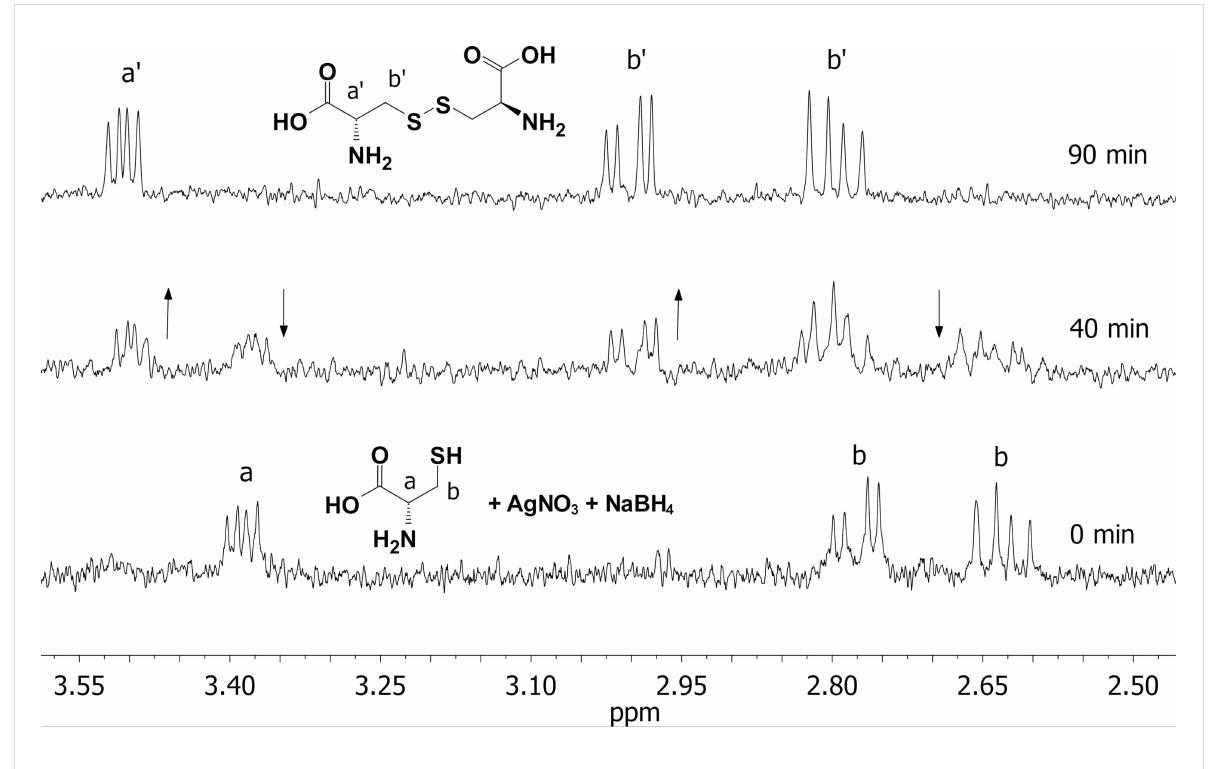
Figure 1: 1 H NMR spectra of the reaction mixture aliquots (5.6 mM cysteine, 56 mM NaBH 4 , and 5.6 mM AgNO 3 , in ultrapure water/D 2 O added) taken at several time points. The arrows show how proton signals (for cysteine and cystine) change with